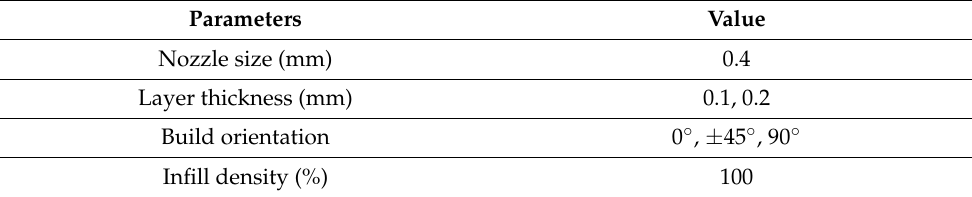
Table 1. Printing Table 1. Printing parameters .